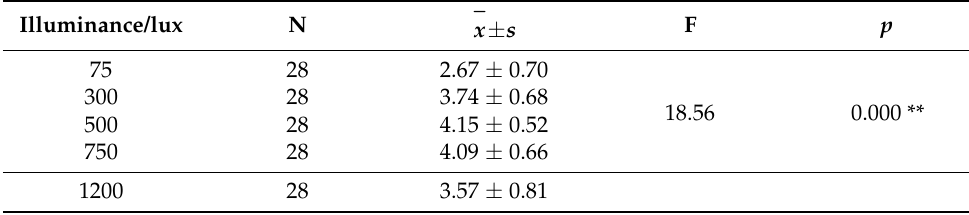
Table 6. Subjective evaluation one-way ANOVA